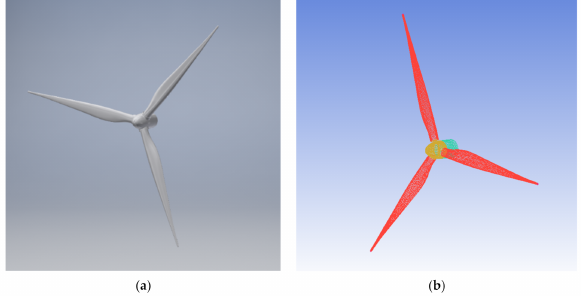
Figure 4. Numerical model of the wind turbine rotor: ( a ) 3D model of the rotor; ( b ) meshing results of the